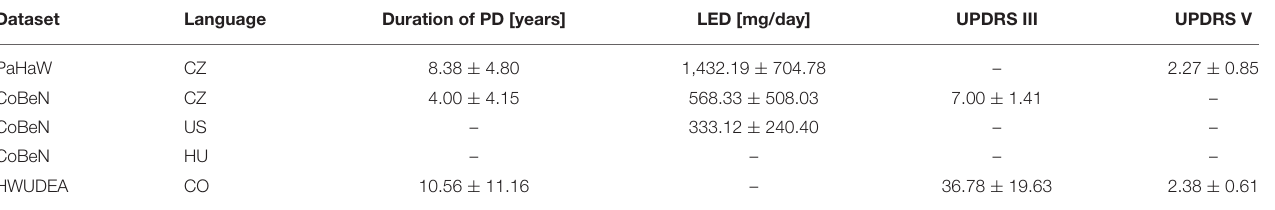
TABLE 3 | Clinical characteristics of the PD patients.